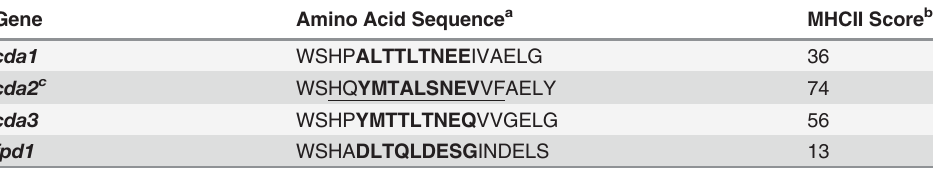
Table 1. CD4+ T cell Cda2-MHCII tetramer peptide sequence and putative cross reactive peptides from other C. neoformans chitin deacetylases. Gene Amino Acid Sequence a MHCII Score b cda1 WSHP ALTTLTNEE IVAELG 36 cda2 c WSHQ YMTALSNEV VFAELY 74 cda3 WSHP YMTTLTNEQ VVGELG 56 fpd1 WSHA DLTQLDESG INDELS 13 The bold sequences indicate regions that align with the P1-P9 residues within the Cda2-MHCII tetramer core. The underlined sequences correspond to the total peptide included in the Cda2-MHCII tetramer. a Homologous amino acid sequences within the catalytic domain of chitin deacetylases. b Peptide loading score on MHCII I-A B (74). c Cda2-MHCII tetramer made from this gene and amino acid